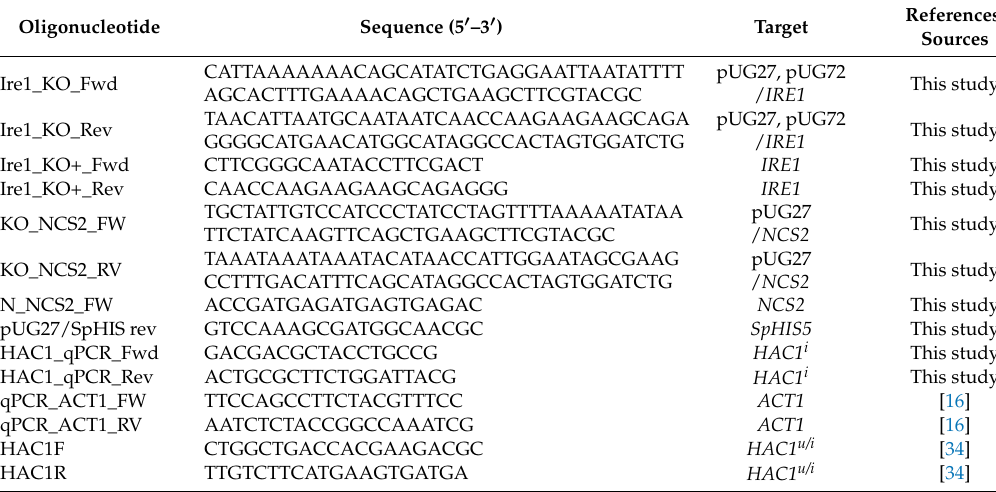
Table 2. Oligonucleotides used in this